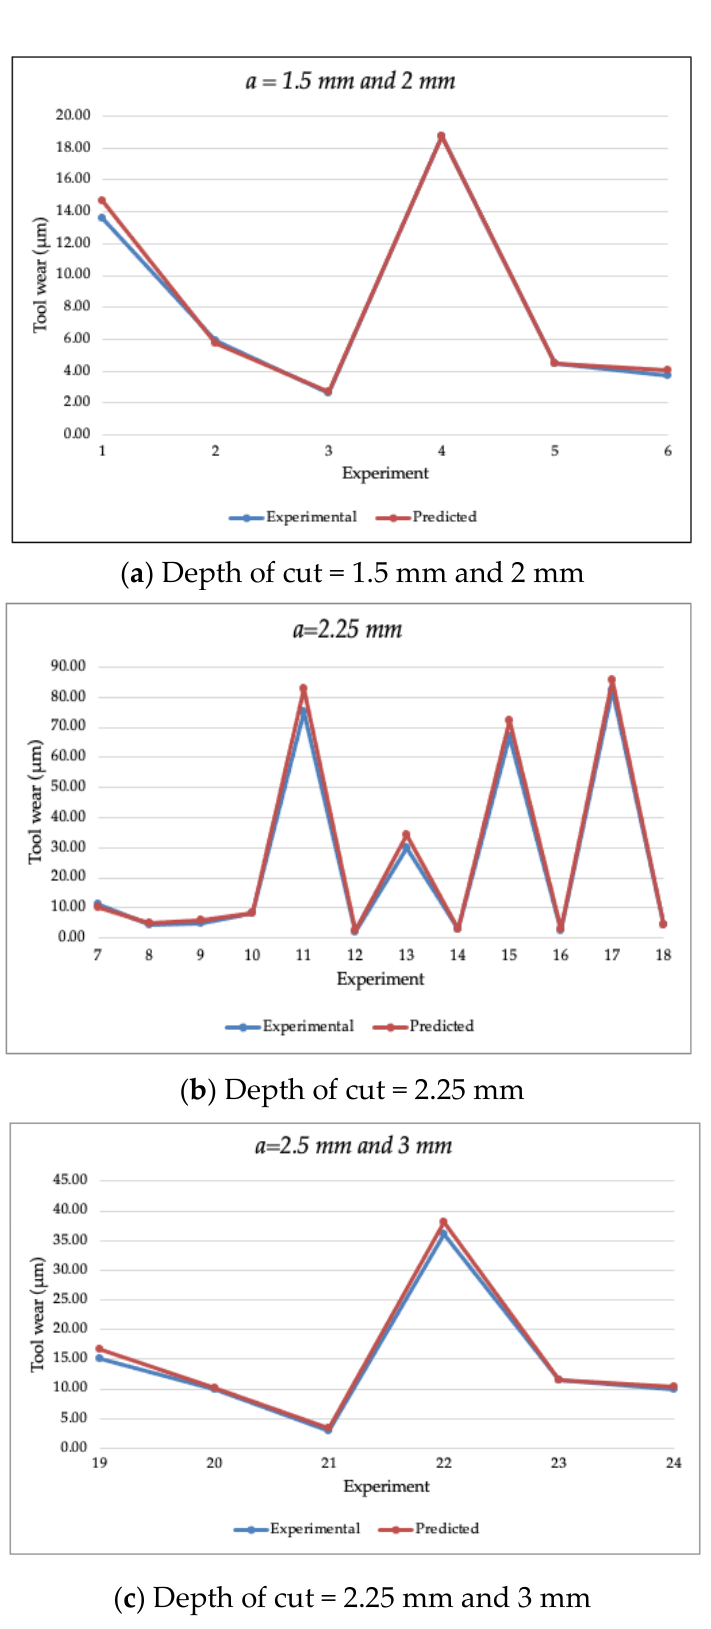
Figure 5. The estimated tool wear of the validation dataset with the various depth of cuts of ( a ) 1.5 mm and 2 mm, ( b ) 2.25 mm, and ( c ) 2.25 mm and 3